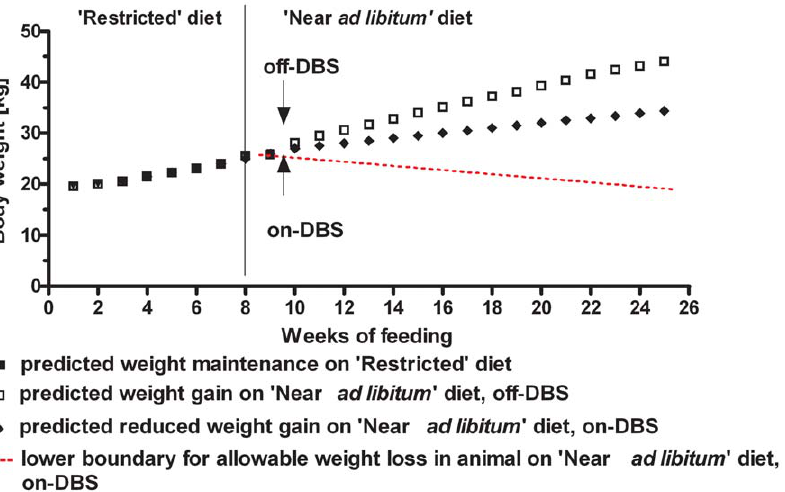
Figure 1. Predicted effect of hypothalamic DBS on weight gain in female Go¨ttingen minipig. Study Design. We hypothesized that low frequency DBS would reduce the weight gain ( ¤ ) or induce a weight loss (red line), based on prior literature data on weight gain in the Go¨ttingen minipig. Predicted values are also shown for weight changes ( & ) on a ‘Restricted’ diet (450 g/day) and for further weight gain ( % ) on a ‘Near ad libitum ’ diet (900 g/day).